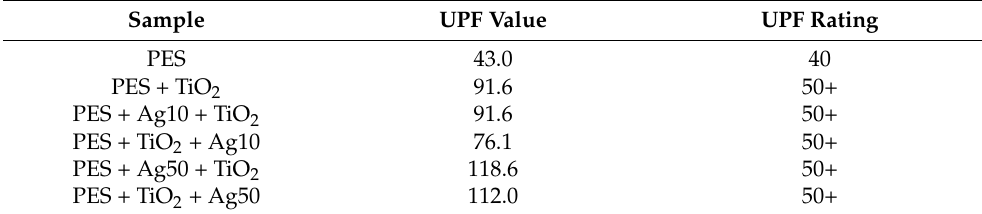
Table 3. UPF values of PES fabrics loaded with Ag and TiO 2 NPs. Used with permission from [75].